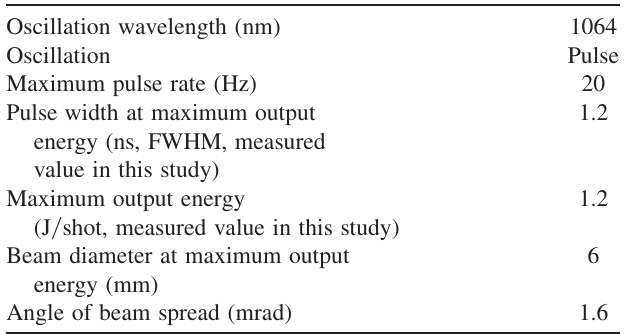
TABLE X. Performance parameters of the Nd:YAG